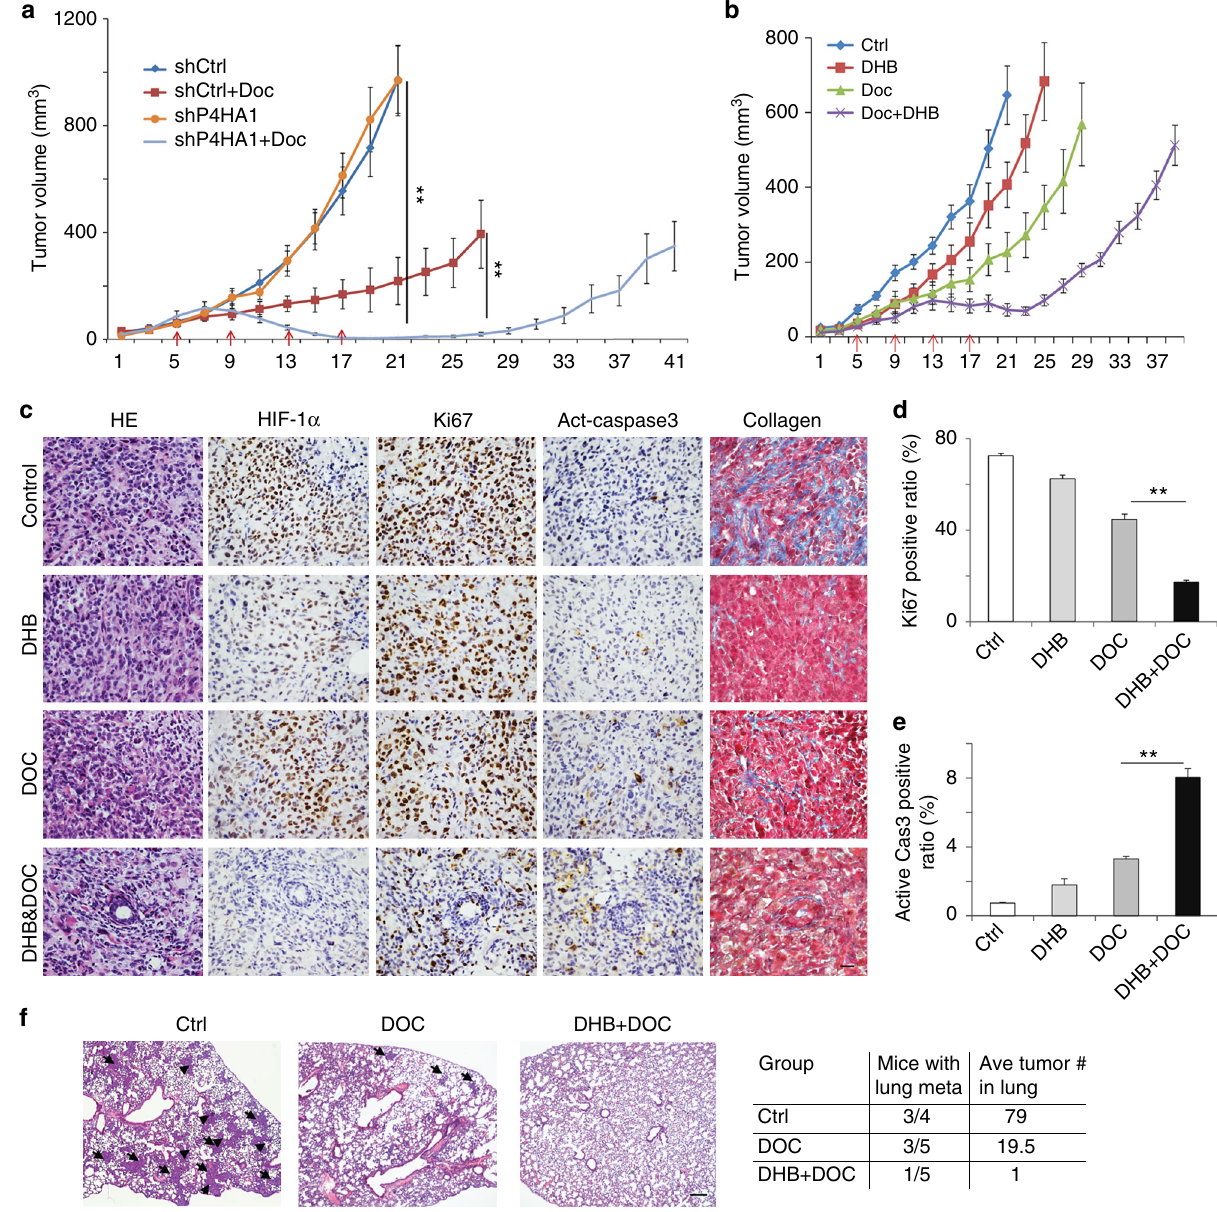
Fig. 7 Inhibition of P4HA1 sensitizes TNBC to docetaxel in vivo. a Tumor growth curve of control and P4HA1-silenced MDA-MB-231 cells implanted mice treated with docetaxel. Results are presented as mean ± SEM; n = 10; ** p < 0.01. The data were analyzed by one-way ANOVA test. b Tumor growth curve of MDA-MB-231 cells implanted mice treated with P4H inhibitor DHB (40 mg/kg) and/or Doc (docetaxel) (10 mg/kg). The DHB treatment started from day 1 to day 21 in the tumor growth curve. Results are presented as mean ± SEM; n = 8. c HE images, IHC staining images (HIF-1 α , Ki-67, active-caspase-3), and Masson ’ s trichrome staining images of tumor sections from mice treated with DHB and/or Doc. Bar: 20 µ m. d , e Quanti fi cation of cell proliferation and apoptosis in tumor sections from mice treated with DHB and/or Doc; n = 4; ** p < 0.01, one-way ANOVA test. f Representative HE images and quanti fi cation data of lung metastasis in mice treated with DHB and/or Doc. Bar: 80 µ